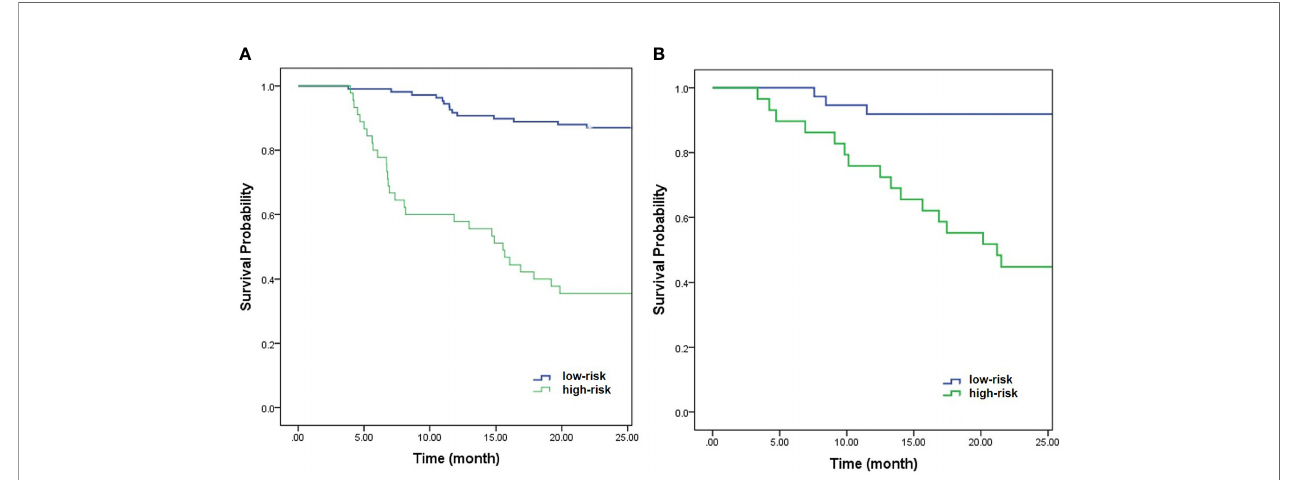
FIGURE 4 | Kaplan-Meier curves of the combined model for 2-year RFS in the training cohort (A) (p < 0.001) and testing cohort (B) (p <